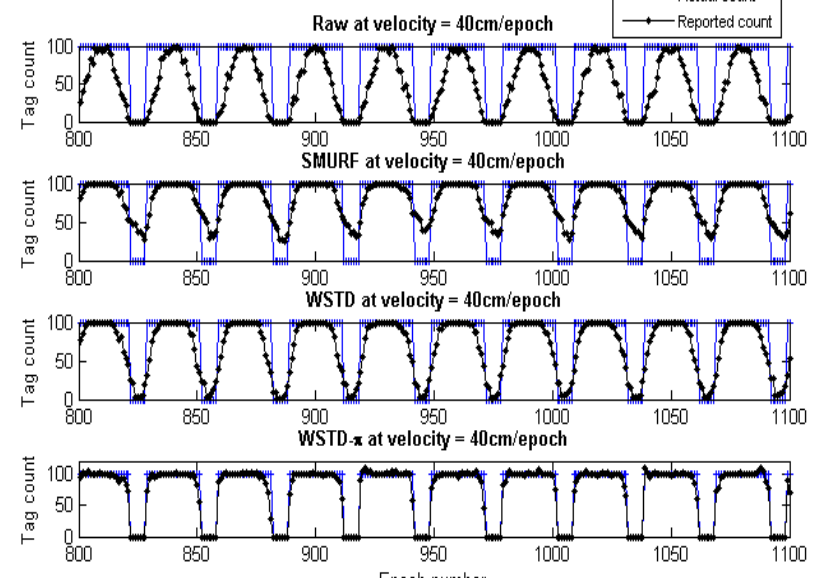
Figure 19. Comparison of variable window-cleaning schemes’ reported tags count with the actual tag count. All the tags move with the same velocity of 0.4